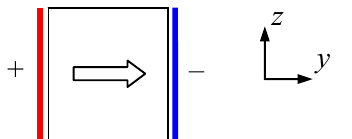
Figure 4. Electrodes configuration of sense